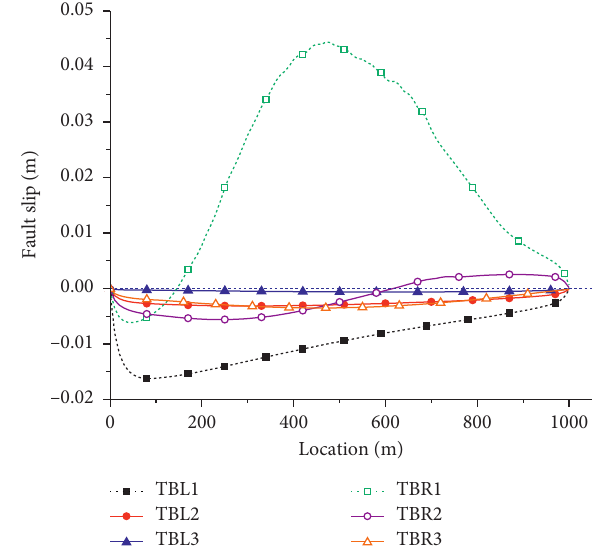
Figure 9: Fault slip along the fault plane when the region of TB changed in the horizontal direction.